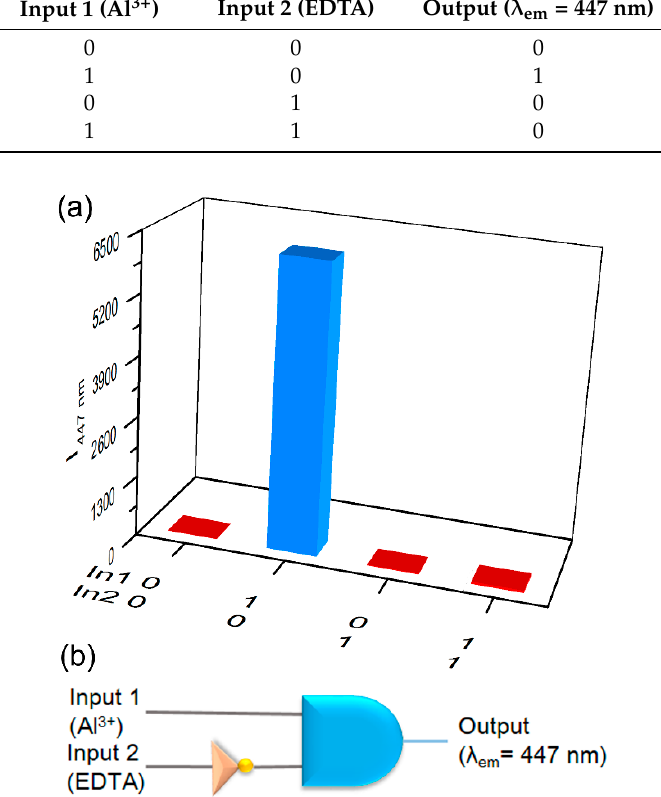
Figure 7. ( a ) The fluorescence intensity of PEGBAB at 447 nm in the presence of four different inputs. ( b ) The circuit diagram for the INHIBIT logic gate. ( b ) The circuit diagram for the INHIBIT logic